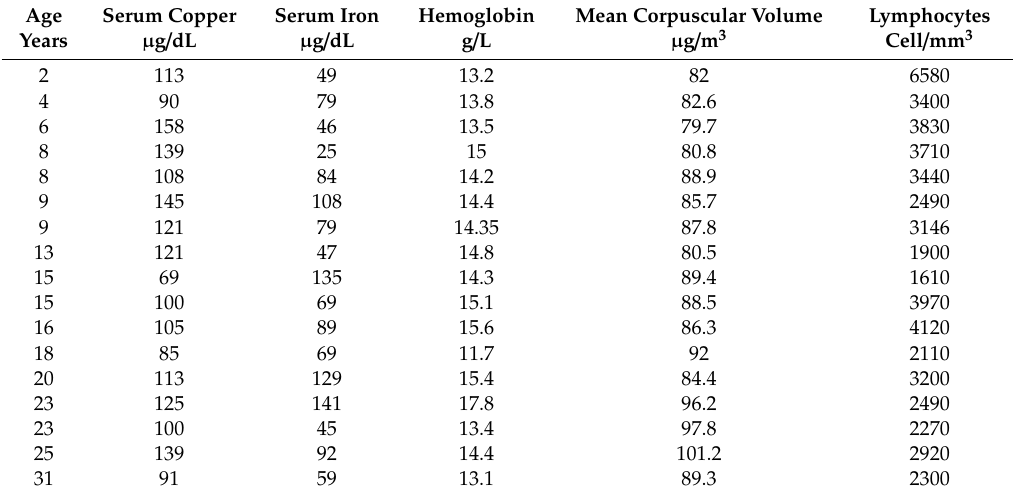
* 17 cystic fibrosis patients were screened, included and